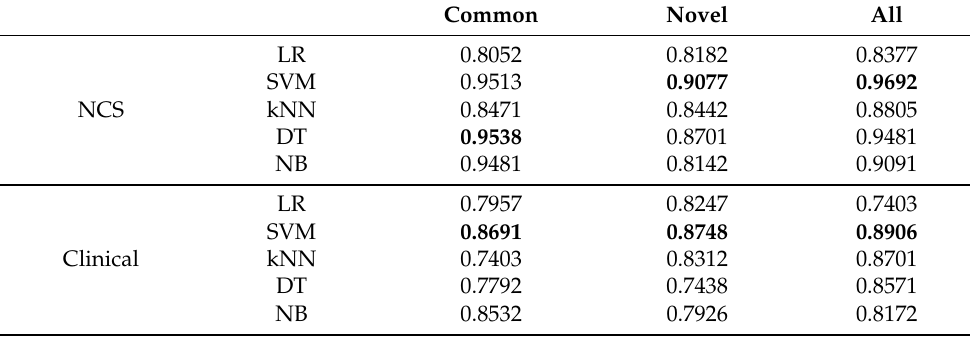
Table 4. Two-class Problem Classification